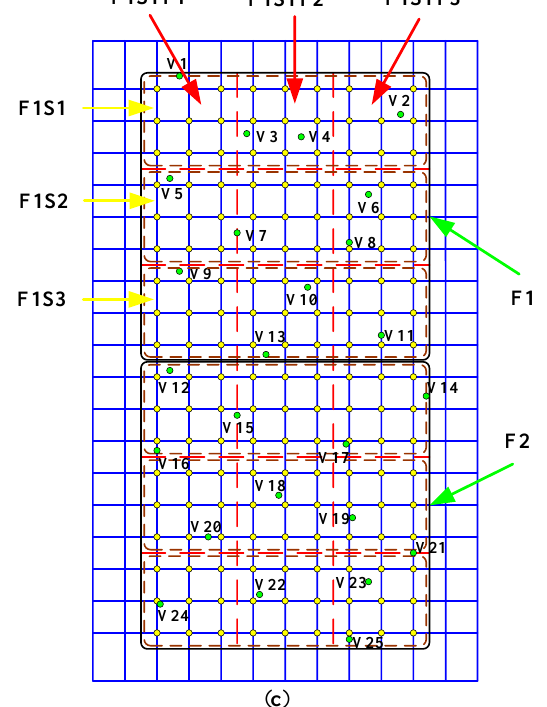
Figure 3. Setting of region divisions, reference points, and validation points for the ( a ) optimisation algorithm, ( b ) PRMCSM algorithm, and ( c ) hybrid algorithm.